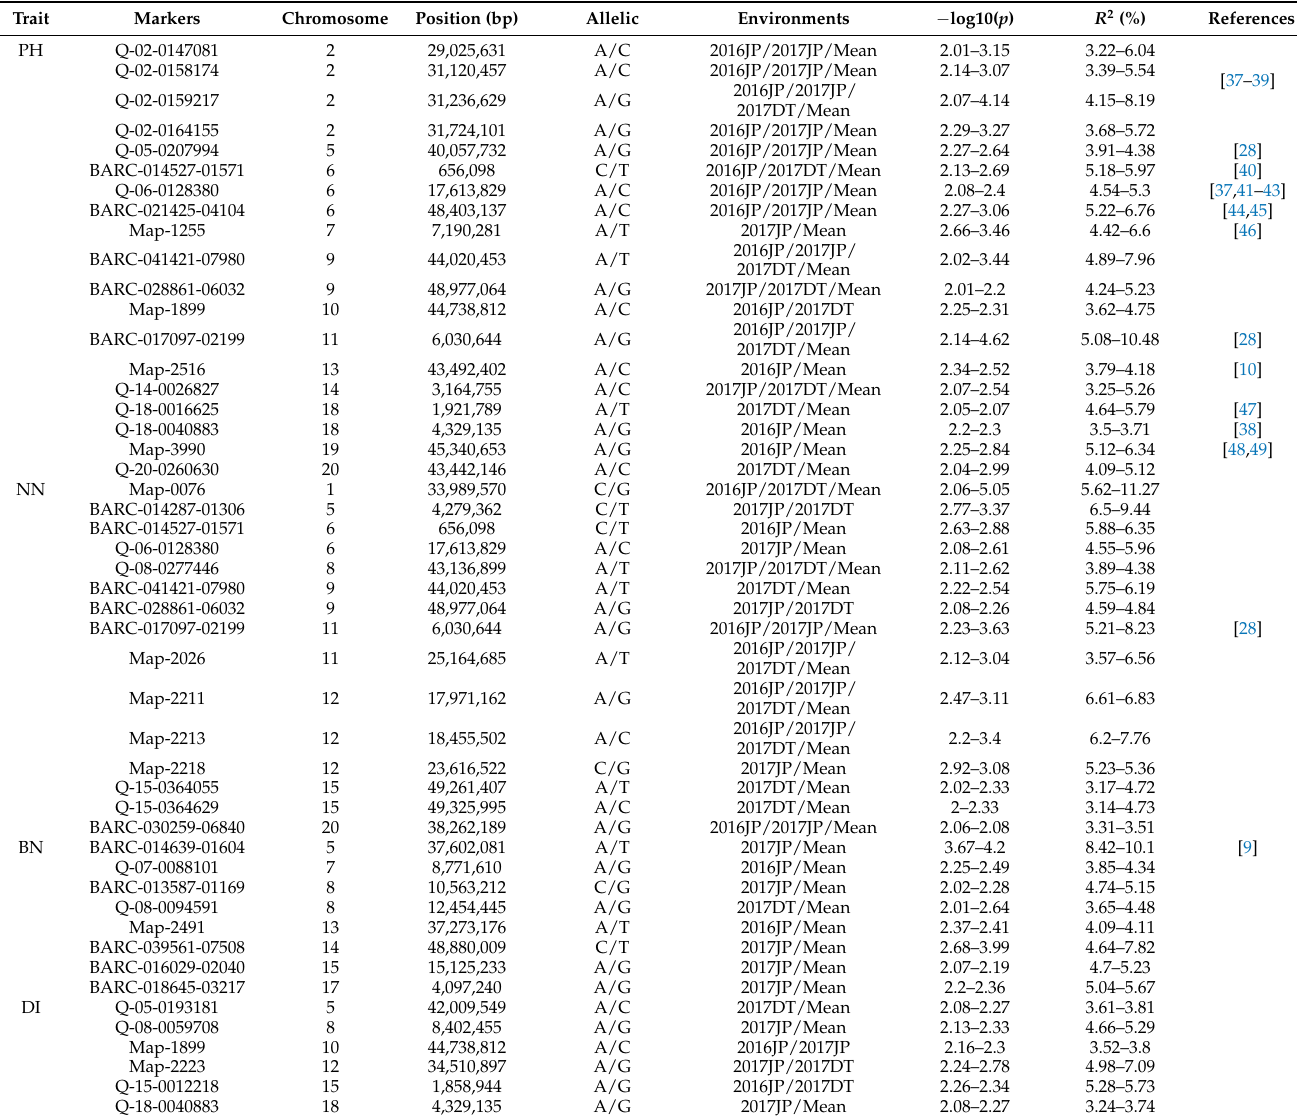
Table 3. Significantly associated SNPs of plant architecture-related traits in soybean mini core